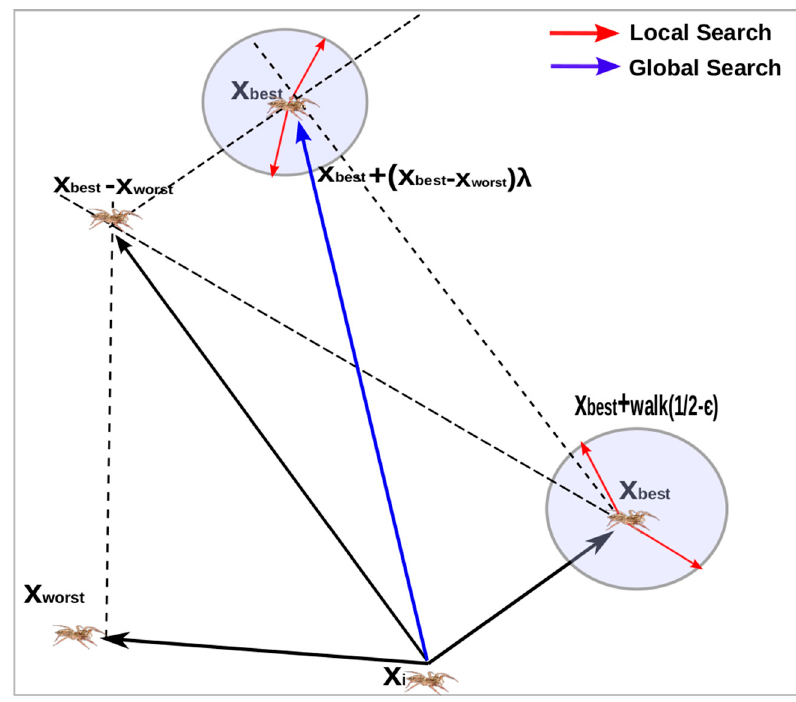
Figure 5. Local and global